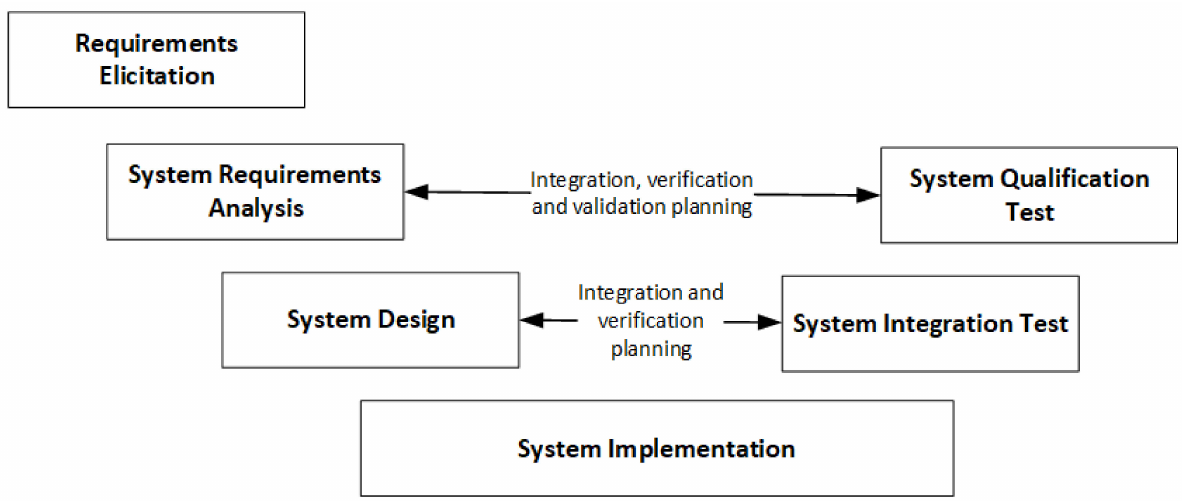
Figure 2. Generic V-model from the system development perspective. Source: Authors’ own, based on